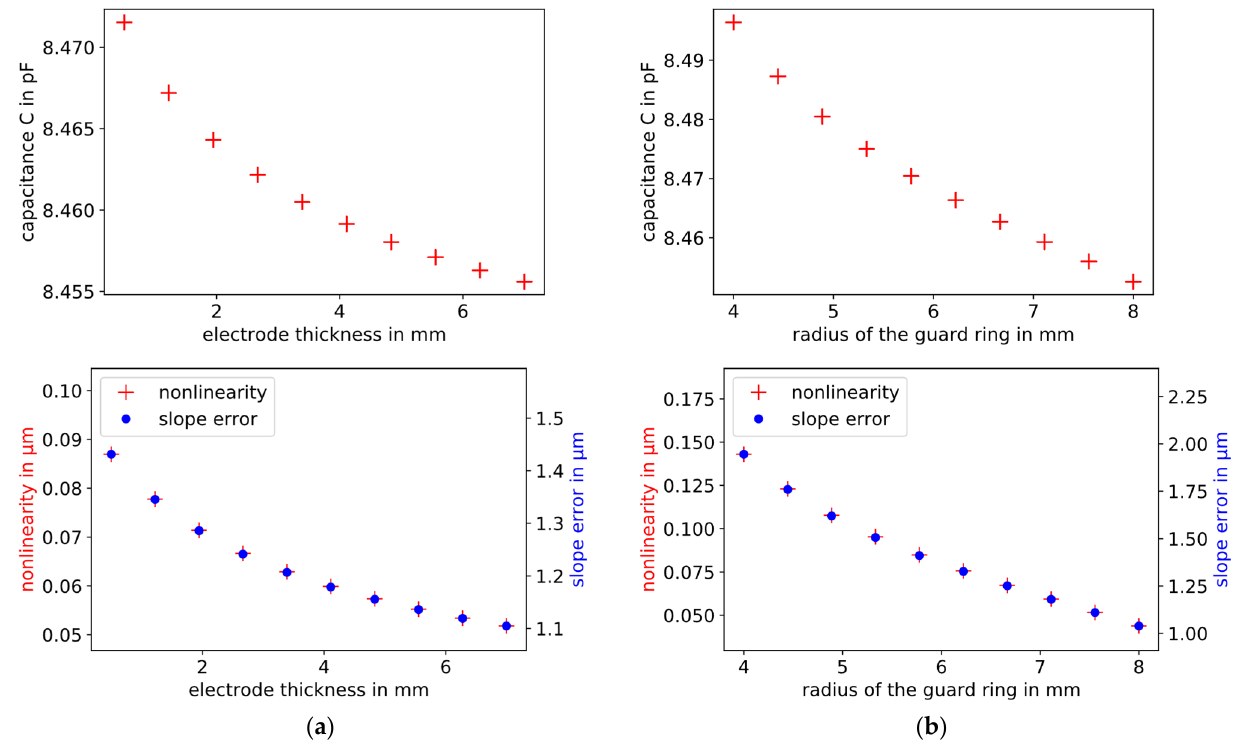
Figure 11. FEM simulation results of the influence of ( a ) the electrode thickness and ( b ) the width of the guard ring of the probe on the capacitance (top, plate distance = 30 µm), and the slope error (blue dots, right scale) and nonlinearity (red crosses, left scale) of capacitive displacement measurements. Due to a thicker electrode and a wider guard ring, the capacitance, the slope error, and the nonlinearity decrease.